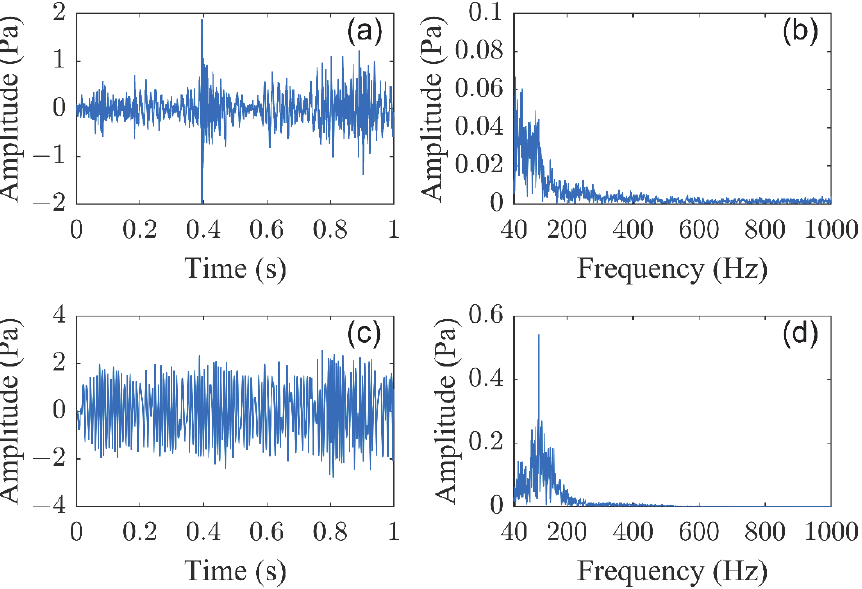
Figure 8. Analyzed results of the noisy signal: ( a ) waveform of the operational signal; ( b ) spectrum of the operational signal; ( c ) waveform of the TFAI-EO-ASR output; ( d ) spectrum of the TFAI- EO-ASR output.